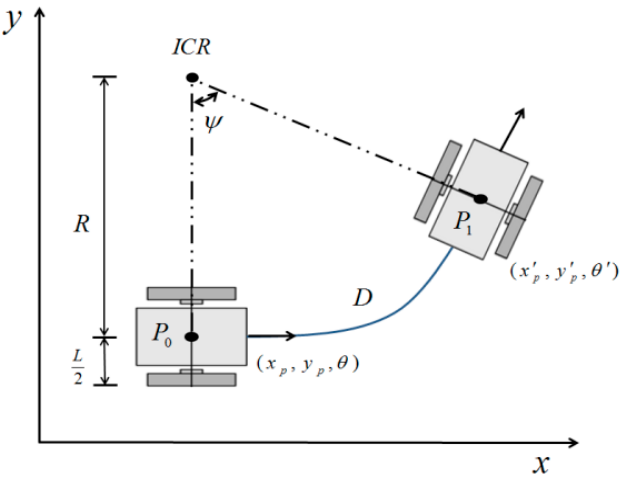
Figure 8. ICR of the mobile robot.